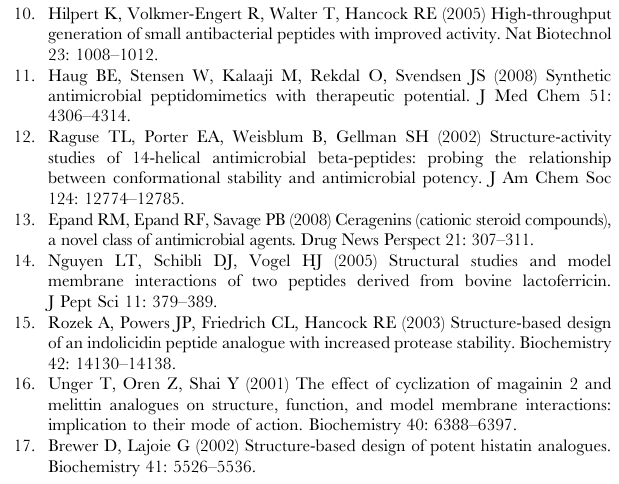
Figure S1 Example ITC isotherms of 2 mM peptide into 0.1 mM serum albumin at 25 u C, fitted using two-site modeling. Profiles of A) Lfc8 titrated into HSA (strongest KD =0.15 mM), and B) Com7 titrated into BSA (strongest KD = 0.21 mM). Found at: doi:10.1371/journal.pone.0012684.s001 (0.46 MB